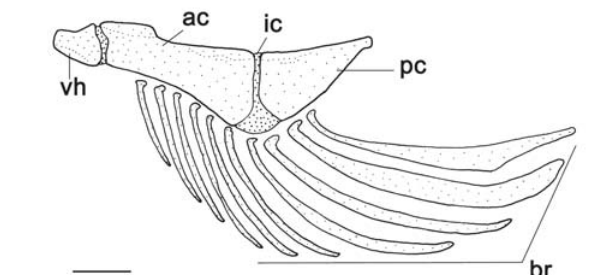
Fig. 5. Left suspensorium of Microglanis pataxo , MNRJ 28398, paratype. Lateral view. Abbreviations: hy, hyomandibula; io, interopercle; mt, metapterygoid; op, opercle; po, preopercle; qu, quadrate. Scale bar, 1 mm.